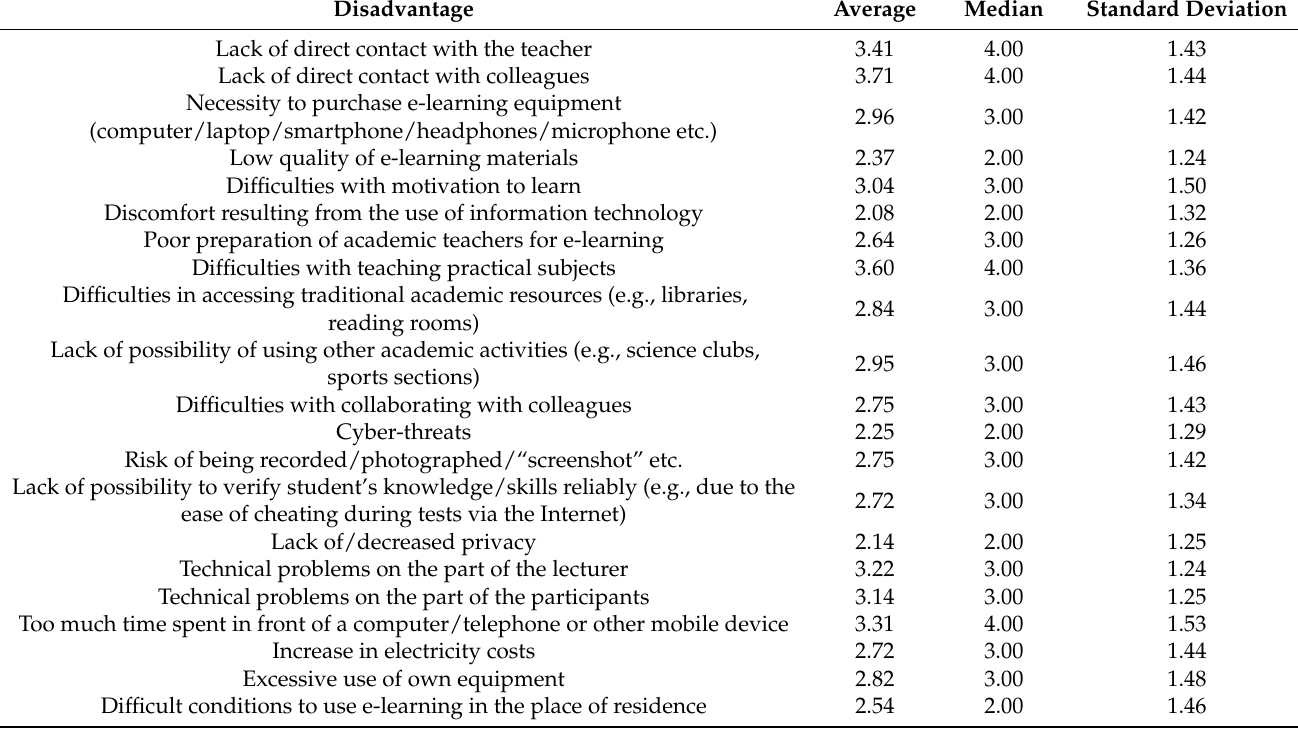
Table 2. The disadvantages of innovative e-learning in higher